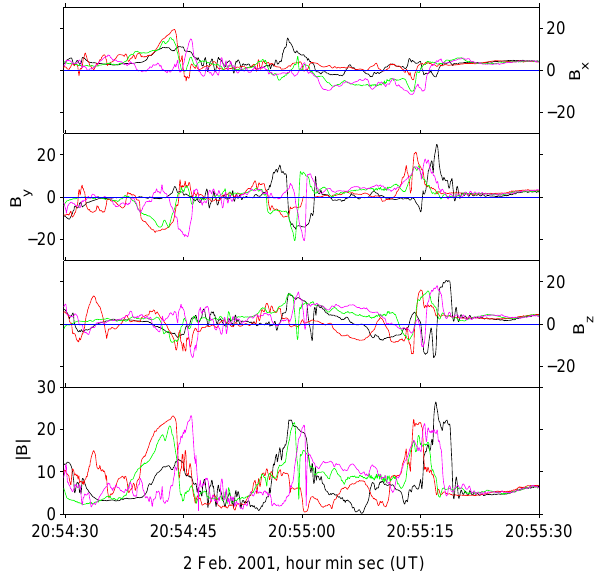
Fig. 6. The variation of the θ Bn angle predicted using the bow shock model normal across the magnetic field enhancement at 20:55:15UT. Panels show the magnetic field elevation ( θ ) and lon- gitude ( φ ) angles in GSE coordinates, the magnetic field magnitude ( | B | ) and θ Bn